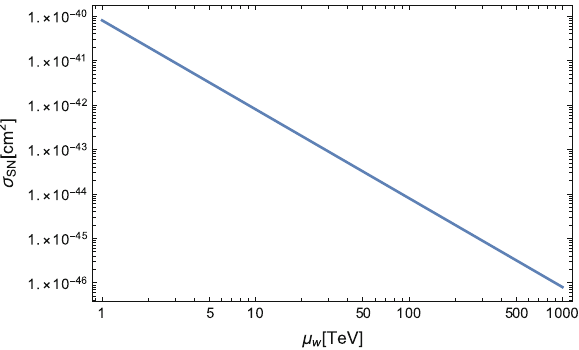
Fig. 5 The skyrmion-nucleon recoil cross section for 1TeV ≤ μ w ≡ g 2 m w / g w h ≤ V